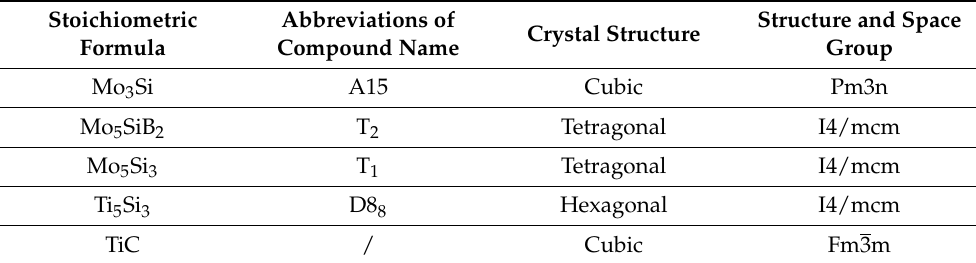
Table A1. Crystal data for some intermetallic